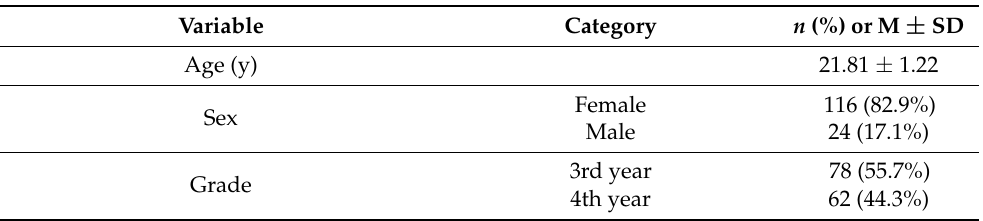
Table 1. General characteristics of the participants ( N =